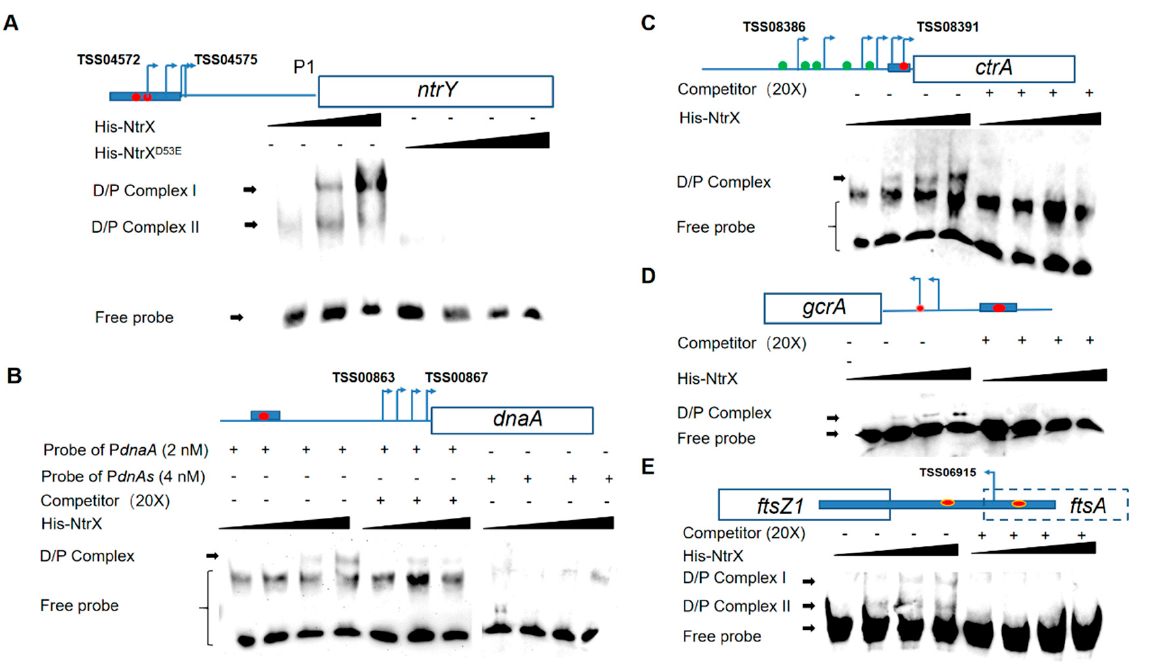
Figure 6. Phosphorylated NtrX proteins binding to the promoter DNA of ntrY ( A ), ctrA ( B ), dnaA ( C ), gcrA ( D ), and ftsZ1 ( E ) in vitro. His-NtrX D53E , the His-NtrX fusion protein containing a substitution of D53E in ( A ). Probe P dnaA s is the DNA probe P dnaA that C AA AACCC TT G was replaced by C GG AACCC CC G in ( B ). D/P complex, DNA-protein complex; competitor, the DNA probe without biotin labeling. Then, 0, 3, 6, and 15 ng His-NtrX proteins mixed with each probe (2 nM), respectively. TSS, transcriptional start sites from the literature [42]. Blue bars, probes for EMSA; red balls, the putative recognition site of NtrX, CAAN 2-5 TTG; green balls, the binding sites of CtrA